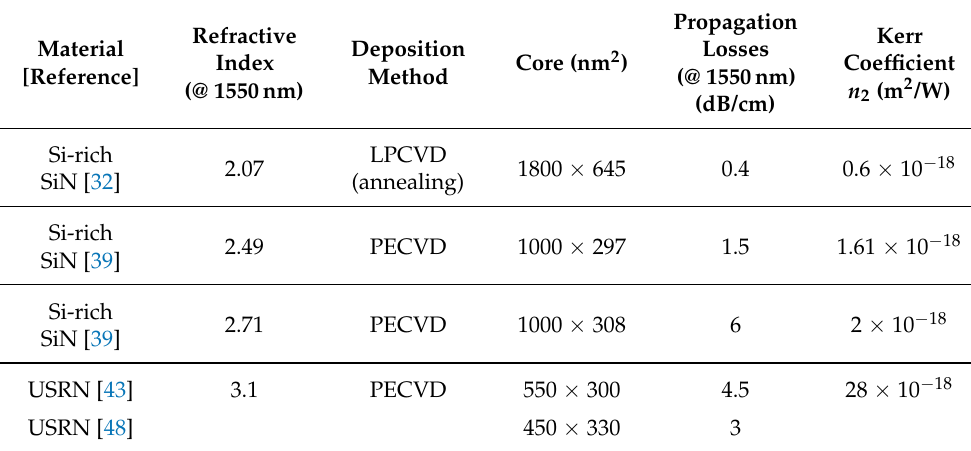
Table 2. Comparison of different Si-rich SiN